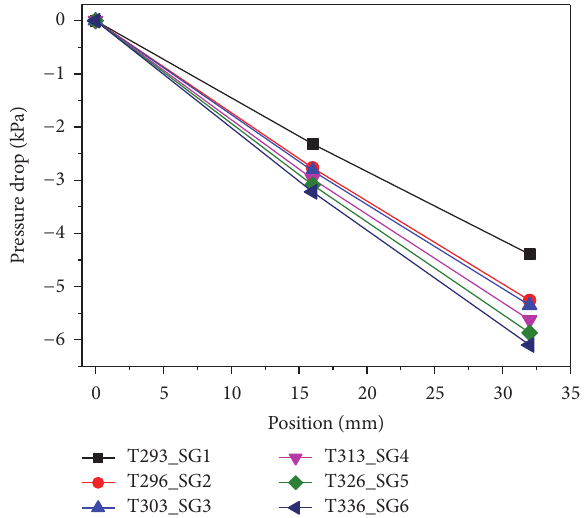
Figure 32: Pressure profiles under various T-H